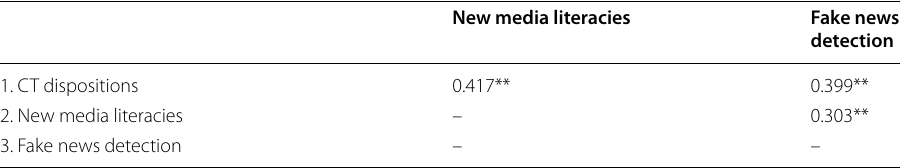
**Correlation is significant at p < 0.01